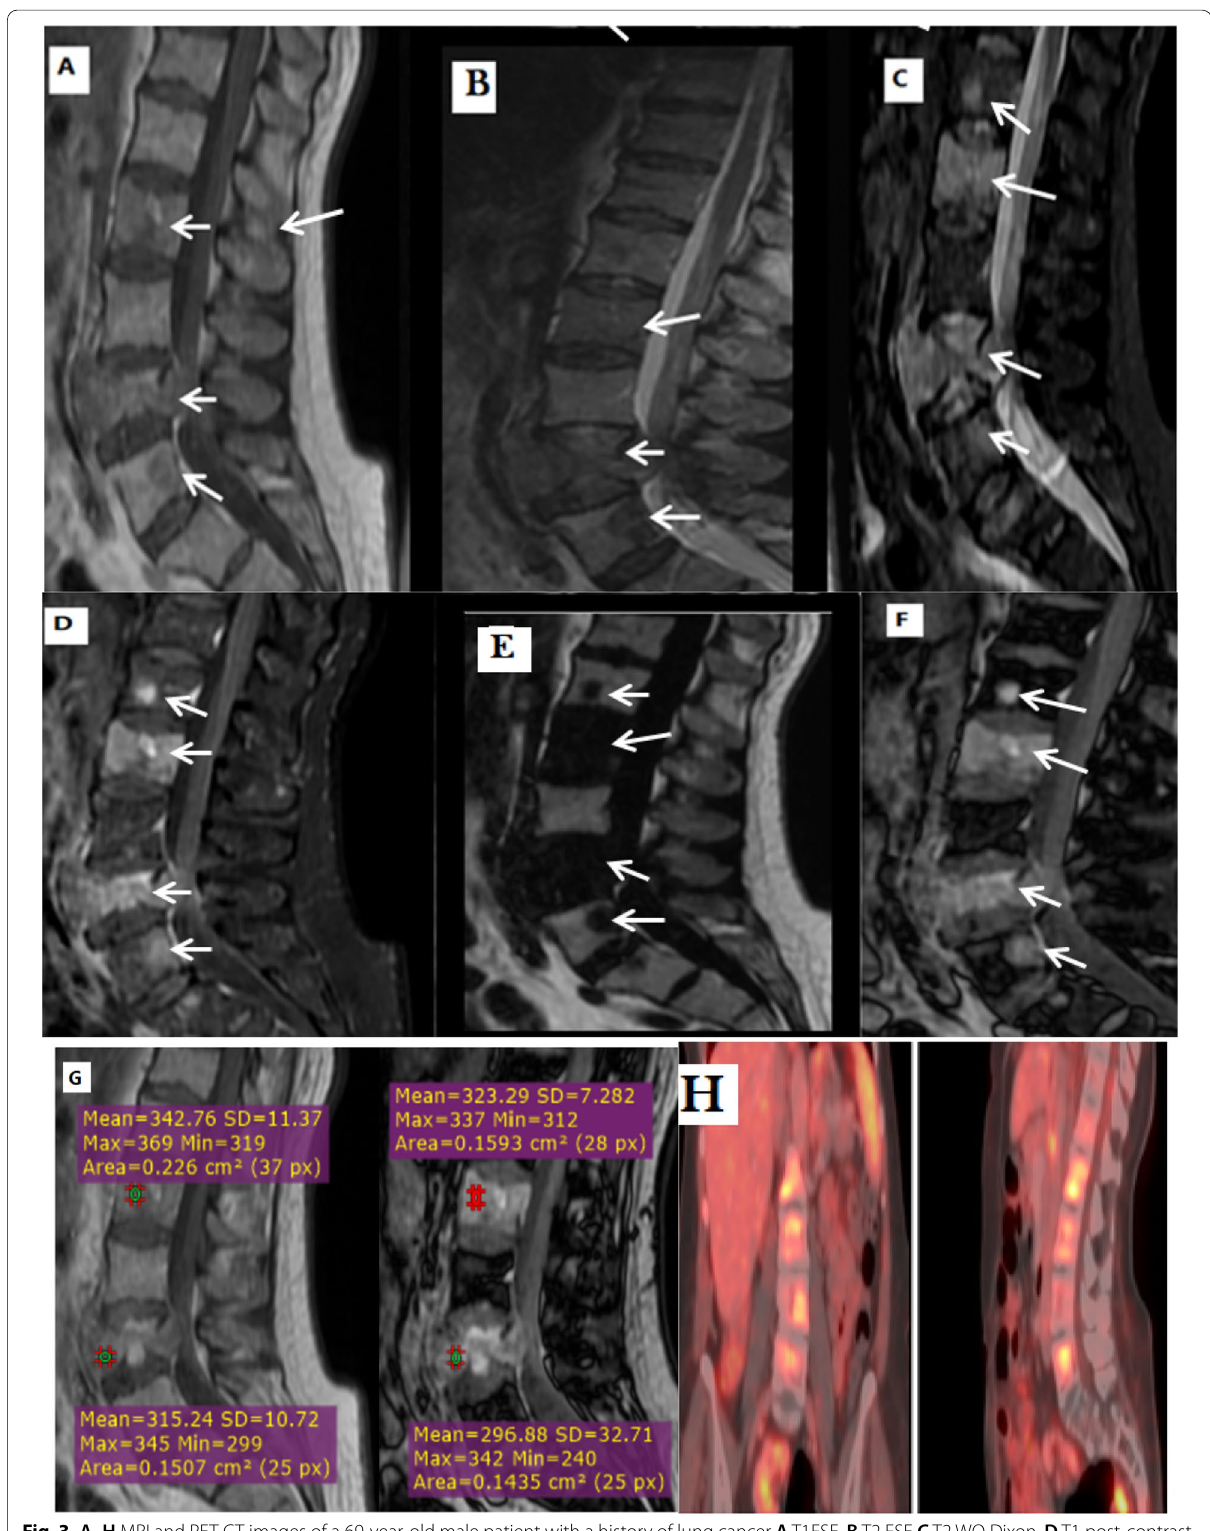
Fig. 3 A – H MRI and PET CT images of a 69-year-old male patient with a history of lung cancer A T1FSE, B T2 FSE C T2 WO Dixon, D T1 post-contrast WO Dixon, E T1FO Dixon F T1 post-contrast OP Dixon, G IP/OP ratio MR images and H FDG PET CT show multiple lumbar vertebral metastasis (white arrows) with IP/OP ratios of two lesions (6% and